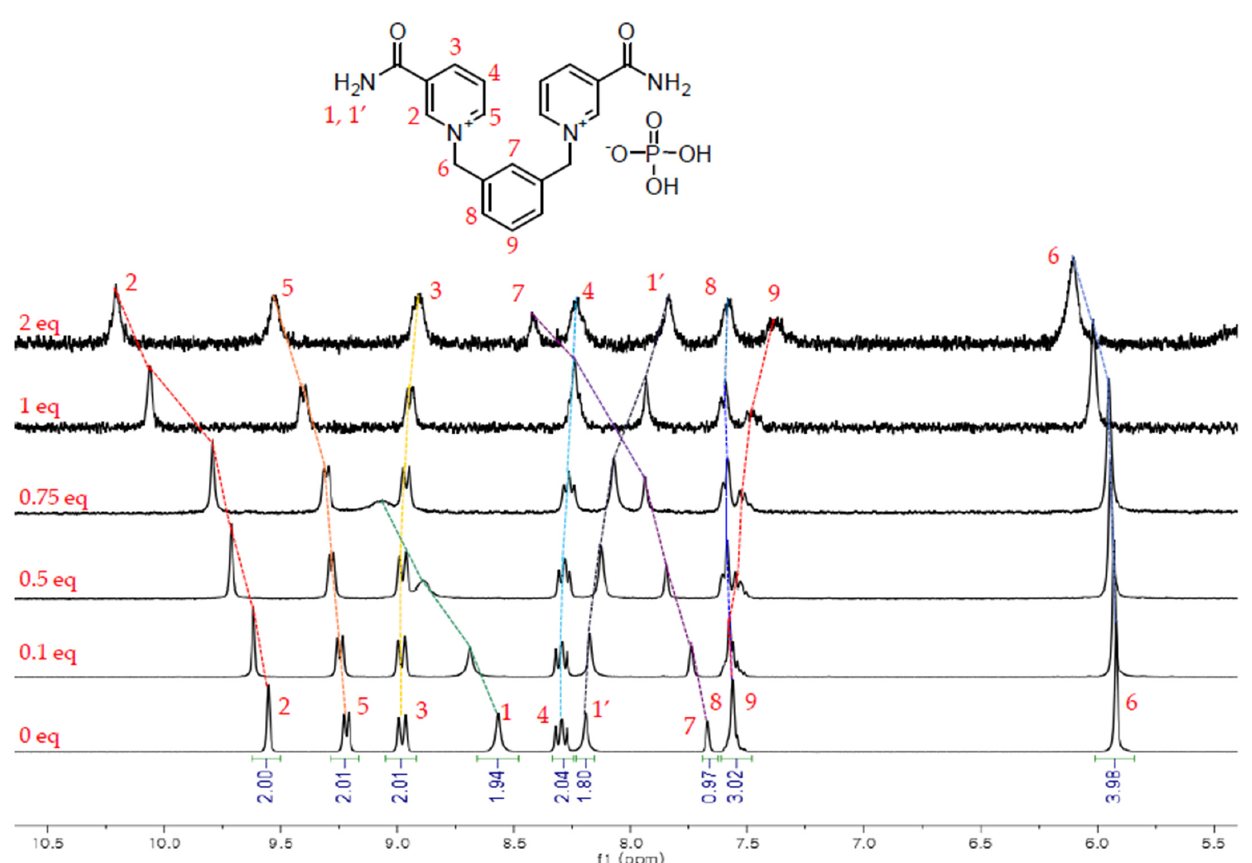
Figure 2 . 1 H-NMR spectra of bis-meta-NICO-PF 6 during phosphate titration. Figure 2. 1 H-NMR spectra of bis-meta-NICO-PF 6 during phosphate